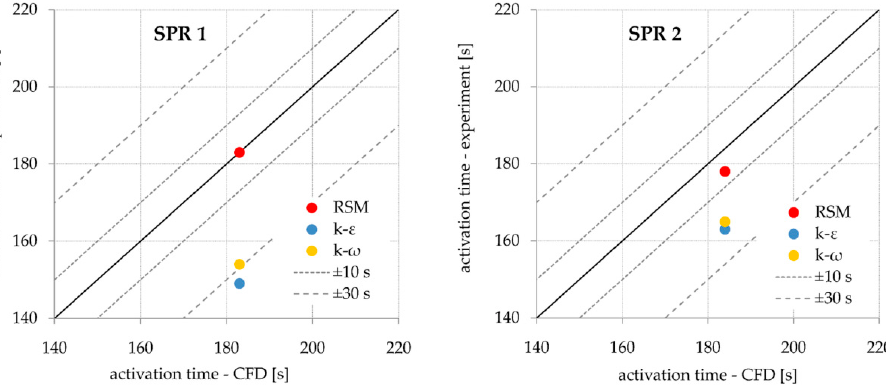
Figure 4. Juxtaposition of calculated and measured sprinklers activation times for Experiment #10.